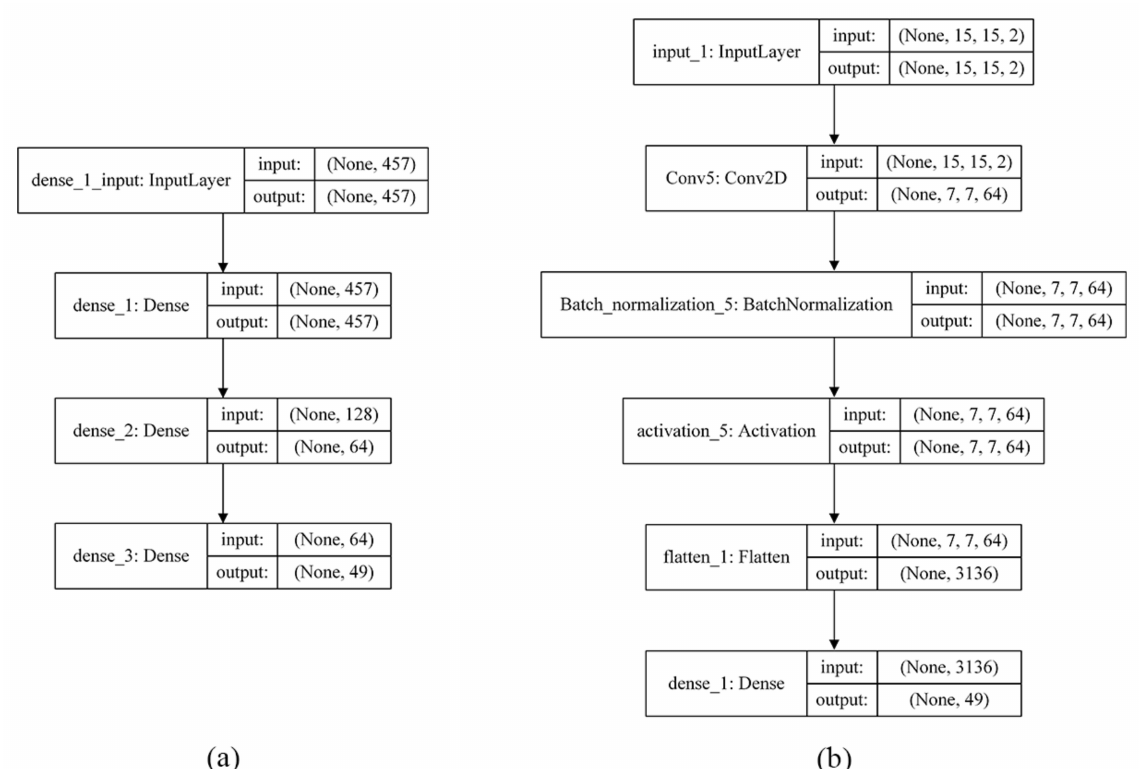
Figure 4. ( a ) Original diagnosis model based on Fully Convolutional Network (FCNN); ( b ) Proposed diagnosis model based on modified CNN. All the experiments were performed on an Intel Core i7-10700F 2.90 GHz machine with 16 GB RAM. The codes of methods were implemented in R 4.0.3 and Python 3.7, with Keras 2.3.1, Scikit-learn 0.22.2.post1, Tensorflow 2.1.0, Lightgbm 2.3.1 and Xgboost 1.0.2. The hyper-parameters related to the model were optimized by Grid Search and manual adjustment. All models were evaluated in the test data